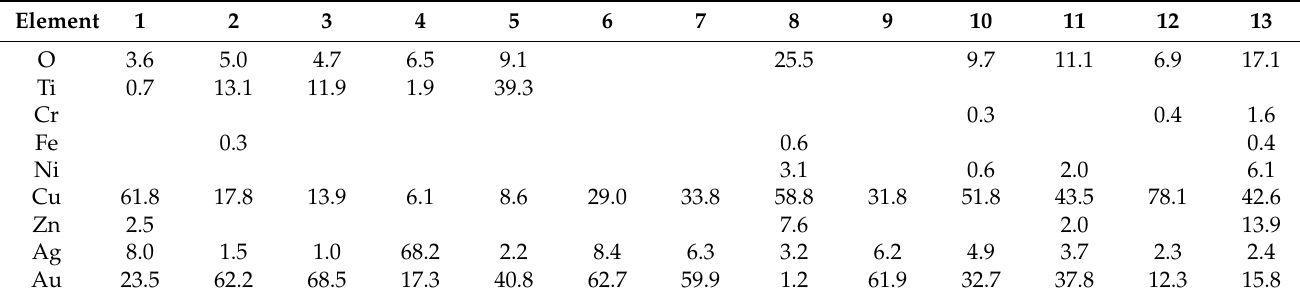
Table 2. EDS compositions (wt.%) of gold-bearing alloys and related mineral phases in iron-oxide ore and pyroclastic rocks from the Kostenga